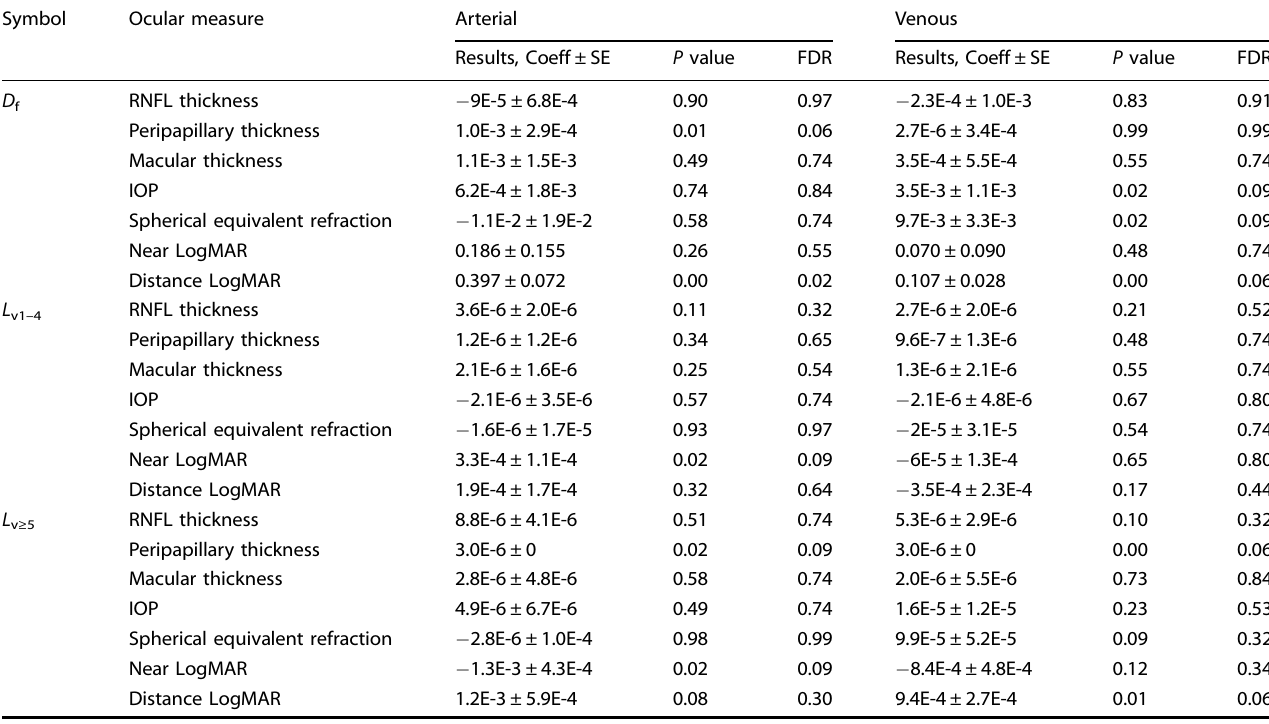
Table 3. Association of ocular measures and arterial and venous density in retinas of 6° HDT subjects after 70 days of bed rest.